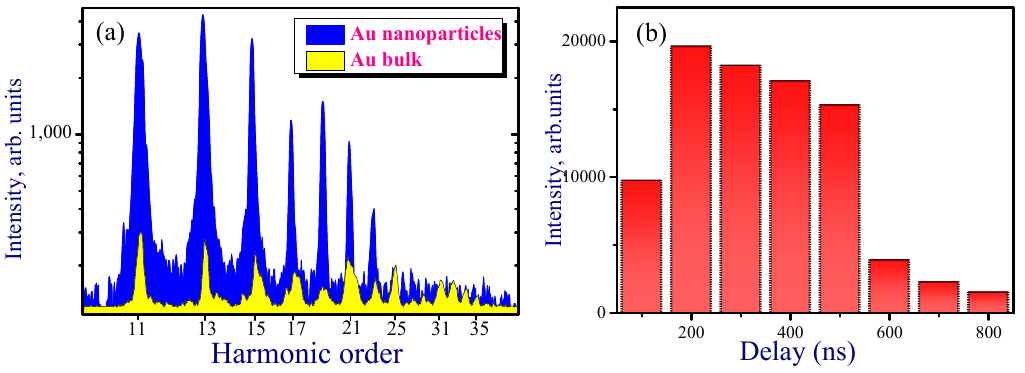
Figure 5. ( a ) High-order harmonic spectra generated in the plasmas produced on the Au thin film and bulk Au. ( b ) Dependence of 11 th harmonic yield on the delay between heating and driving pulses.